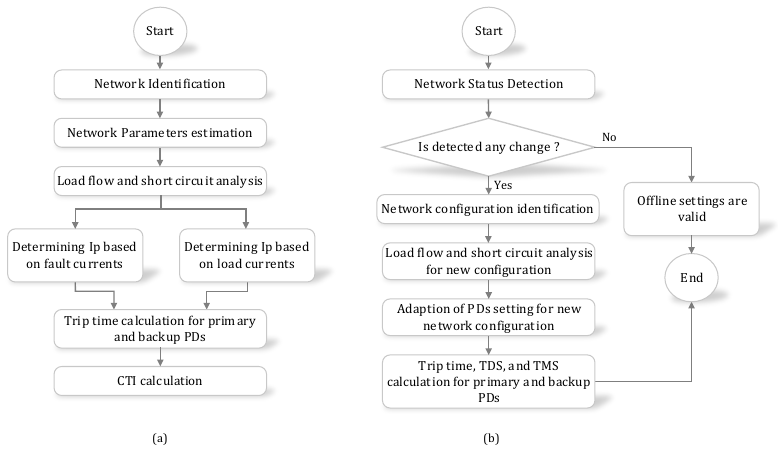
Figure 7. The proposed algorithm for MG protection: ( a ) offline mode setting, and ( b ) adaptive online mode for setting